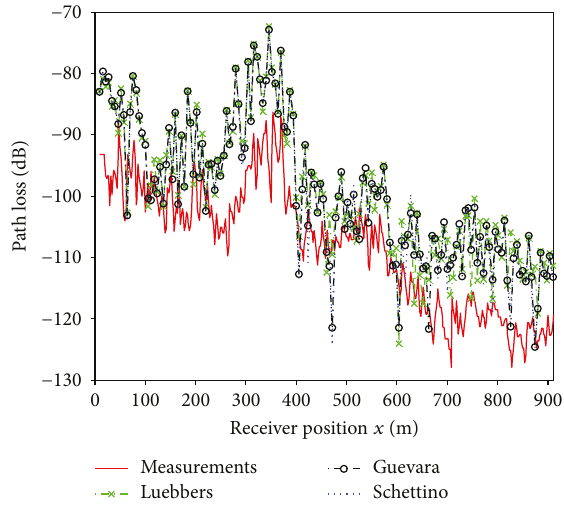
Figure 16: Path loss comparison of model and measured data (red line) for Laurier St.